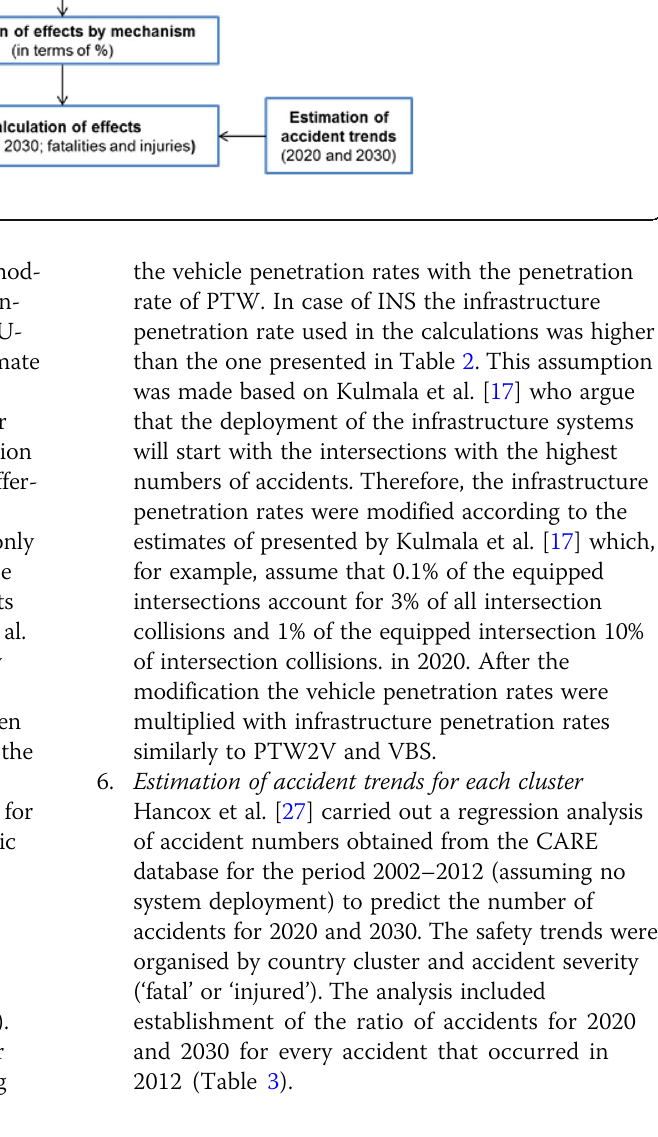
Table 2 Estimate of implementation rates for the selected ITS applications for 2020 and 2030 System